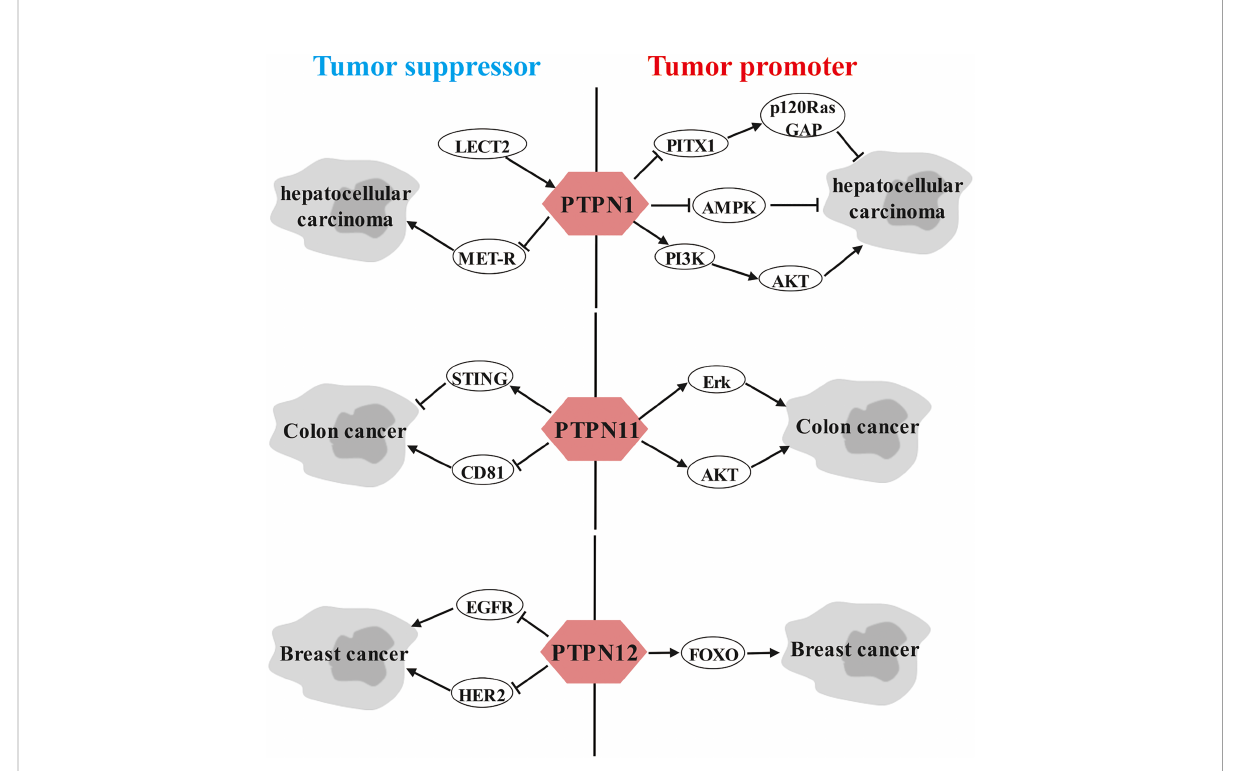
FIGURE 2 Dual role of PTPNs in speci fi c